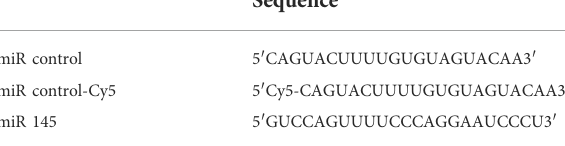
TABLE 1 compilation of sequences of the miR used in this